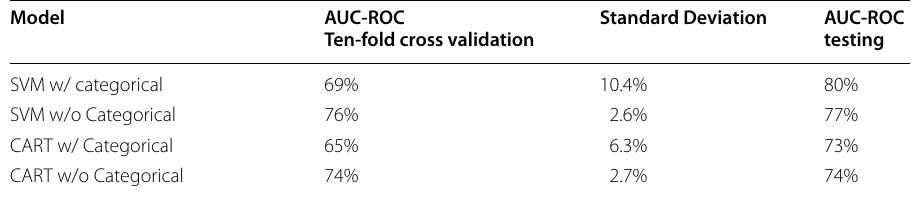
Table 14 Results: Prediction accuracy with SVM and CART